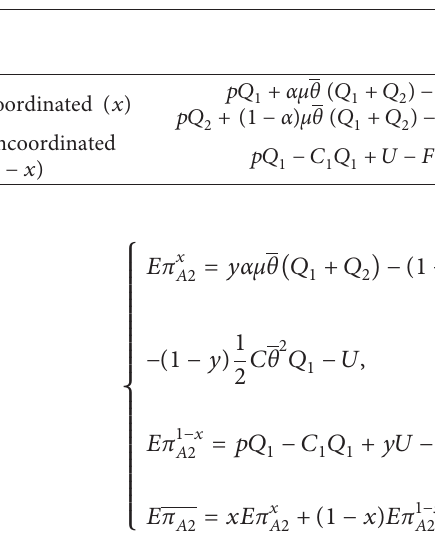
Figure 1: Phase diagram of system evolution without government Table 3: Payment matrix of fresh agricultural product suppliers A and B with government participation.